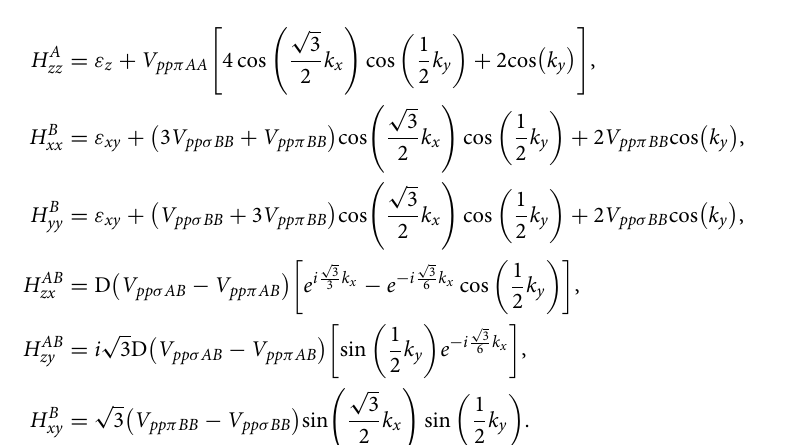
Figure 3. ( a ) Direct band gaps at Γ point and topological phases versus the SOC magnitude. The ‘NI’ and ‘QSHI’ mean the normal and QSH insulators, respectively. ( b ) Schematic plot of a bitriangular lattice with Po A p z and Po p x , y orbitals. (c) Band structures from the TB model based on the bitriangular lattice with (cid:31) = 0.0, 0.5, B and 1.0